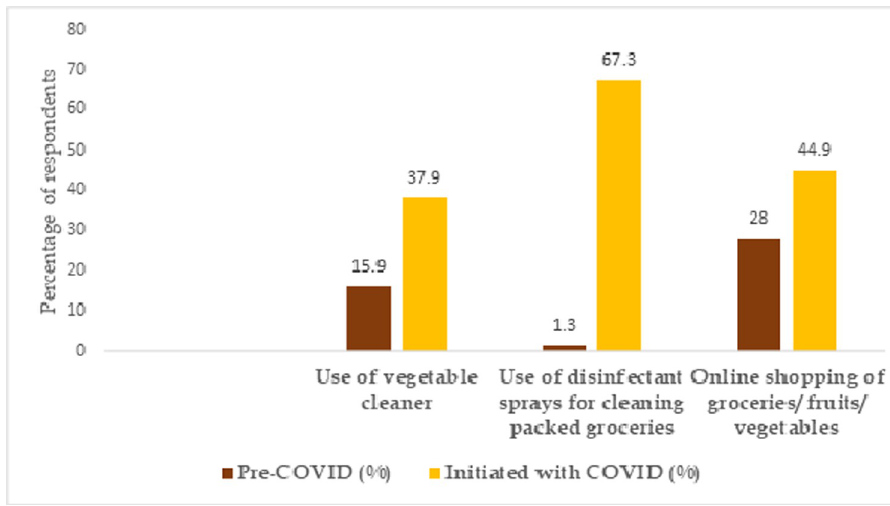
Fig 4. The food safety practices picked up or escalated during the COVID